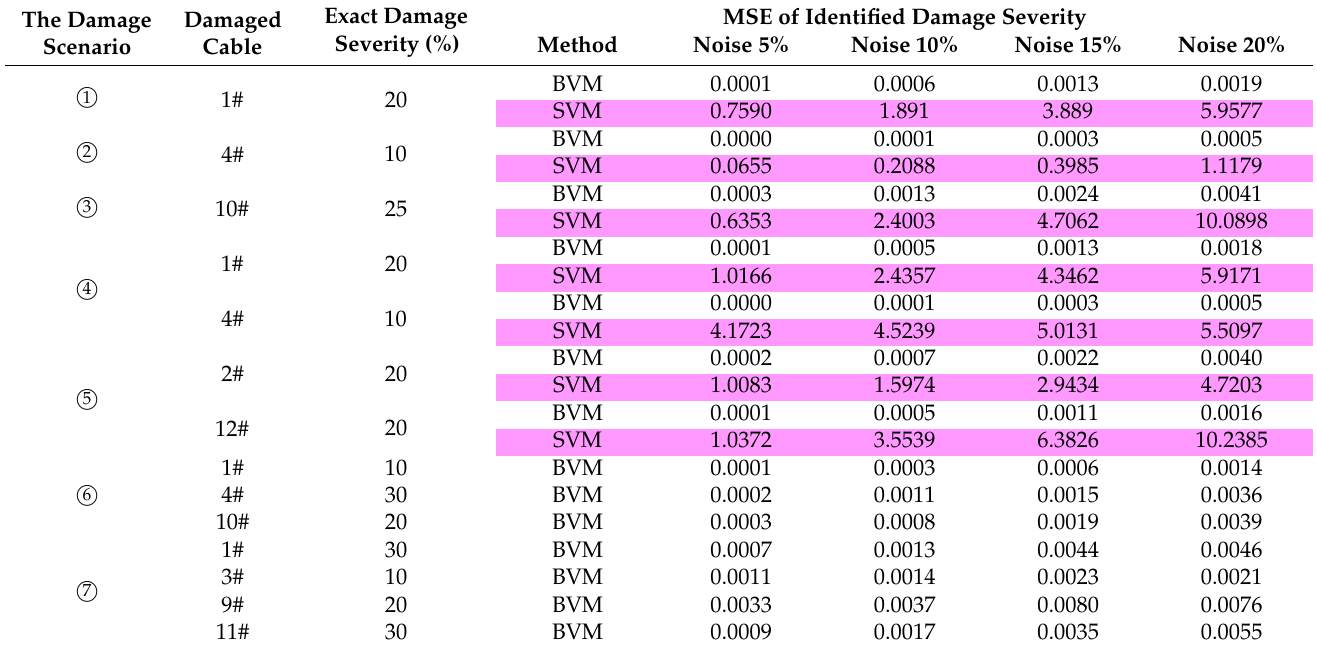
Table 7. The MSE of the identified damaged severity of the 7 damage scenarios’ test dataset using the BVM method and the SVM method